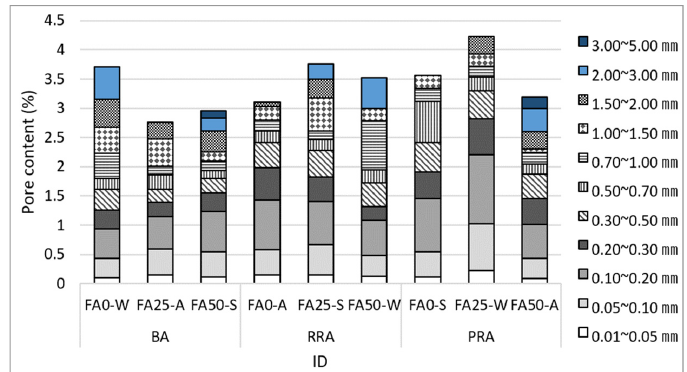
Figure 14. Relative dynamic modulus of elasticity of concrete depending rapid freezing and thaw- ing.